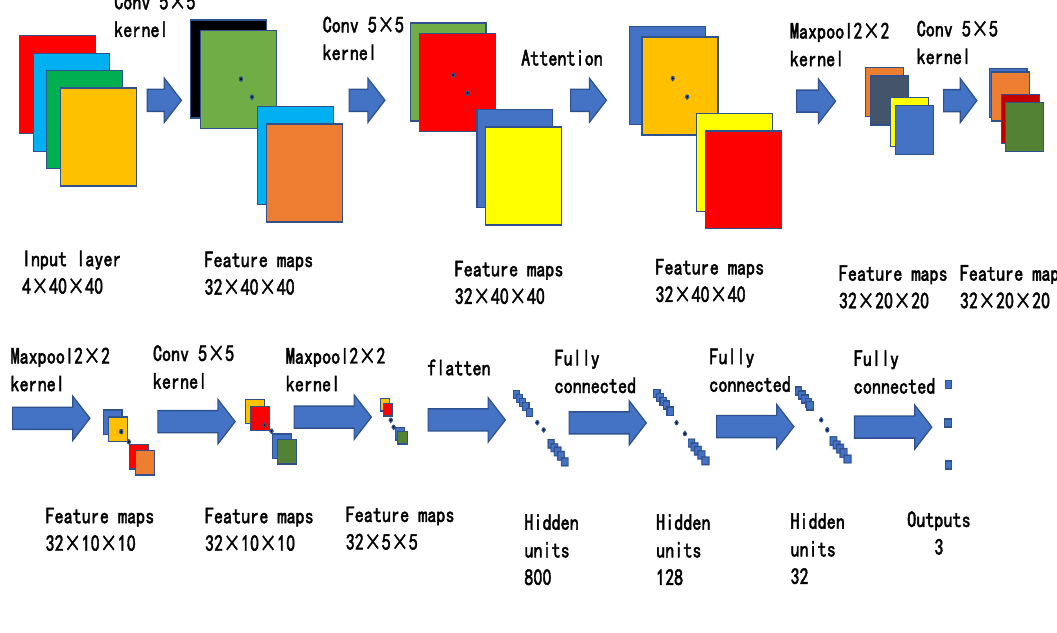
Figure 2 . Illustration of the jet-tagging